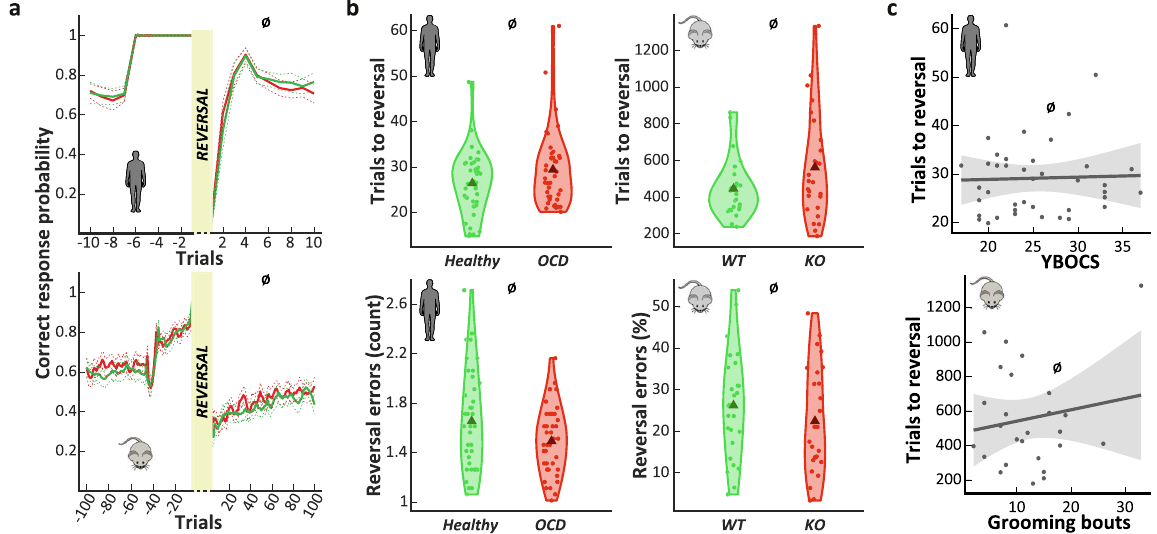
Fig. 2 Compulsivity is not related to behavioral fl exibility. a Changes in correct response probability around a reversal. Top: for humans with 10 trials around the reversal. Red line: OCD patients. Green line: healthy subjects. Bottom: for mice with 100 trials around the reversal. Red line: Sapap3 KO mice. Green line: WT mice. The data were smoothed using Savitzky – Golay algorithm for both species. b No difference was found between groups for both humans (left, n = 40 per group) and mice (right, n = 26 per group), neither when considering the number of trials needed to reach the reversal criterion (top) or the number of reversal errors (bottom). Triangle: group mean. Dot: individual mean. Ø: BF 10 < 1. c Top: In OCD patients, the disease severity assessed by the Y-BOCS does not predict the number of trials needed to reach the reversal criterion. Dark line: linear fi t. Gray area: con fi dence interval. Bottom: In Sapap3 KO mice, compulsive grooming severity assessed by the number of grooming bouts initiated (over a 10-min period) does not predict the number of trials needed to reach the reversal criterion. Dark line: linear fi t. Gray area: con fi dence